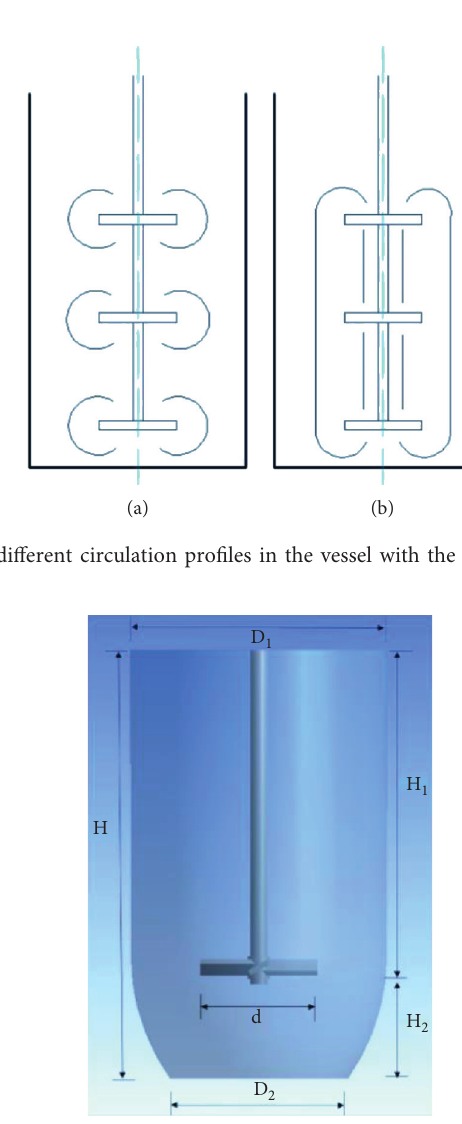
Figure 8: Stagnant region and a dead zone in multistage stirrer [12]. (a) Single-stage stirrer. (b) Two-stage stirrer. (c) The multi-stage stirrer.